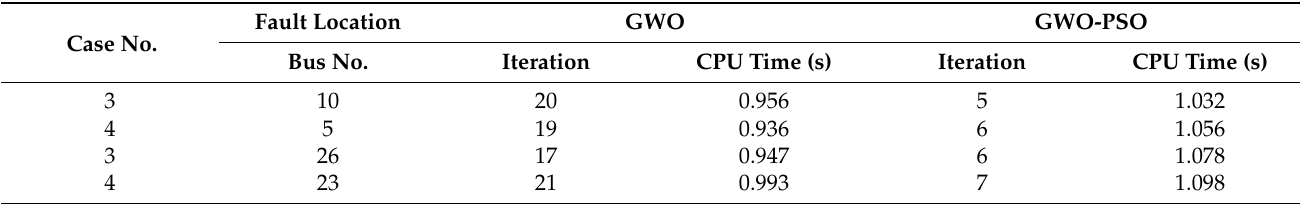
Table 7. Comparing computational time and iterations taken by an optimization algorithm for the non-adaptive part of the hybrid protection scheme. Table 8. Comparing computational time and iterations taken by an optimization algorithm for the adaptive part of the hybrid protection scheme.